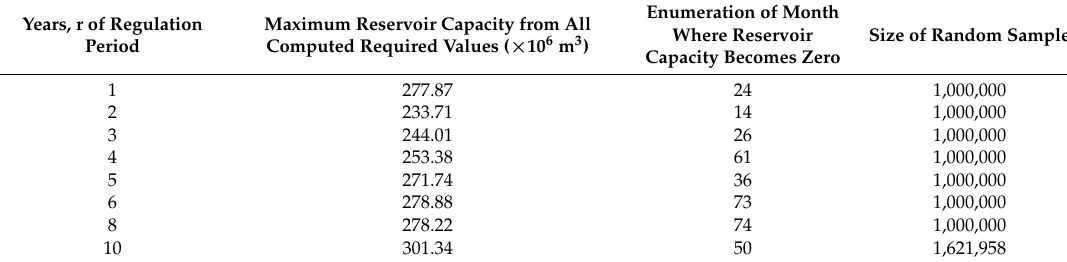
Table 6. Summary of results from the Second Method.